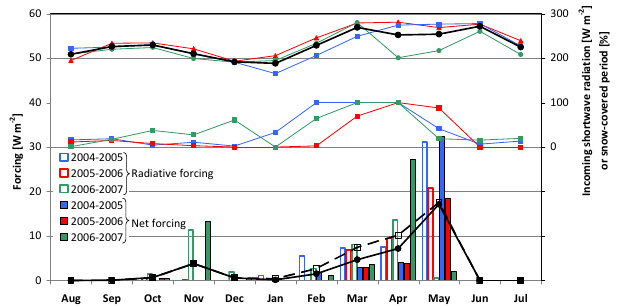
Figure 8. Simulated monthly mean radiative (open bars) and net forcing (filled bars) for the seasons 2004/2005 (blue), 2005/2006 (red), and 2006/2007 (green) due to the presence of 100ppb of BC in the snow. Black open squares and filled circles indicate 3-year av- erages of the monthly means of the radiative and net forcing. Also shown are snow-covered periods in percent based on the simula- tions without BC in the snow (middle) and the monthly means of the observed incoming shortwave radiation (top) for the 3 years. The black circles in the top panel indicate the 3-year average of the monthly means of the incoming